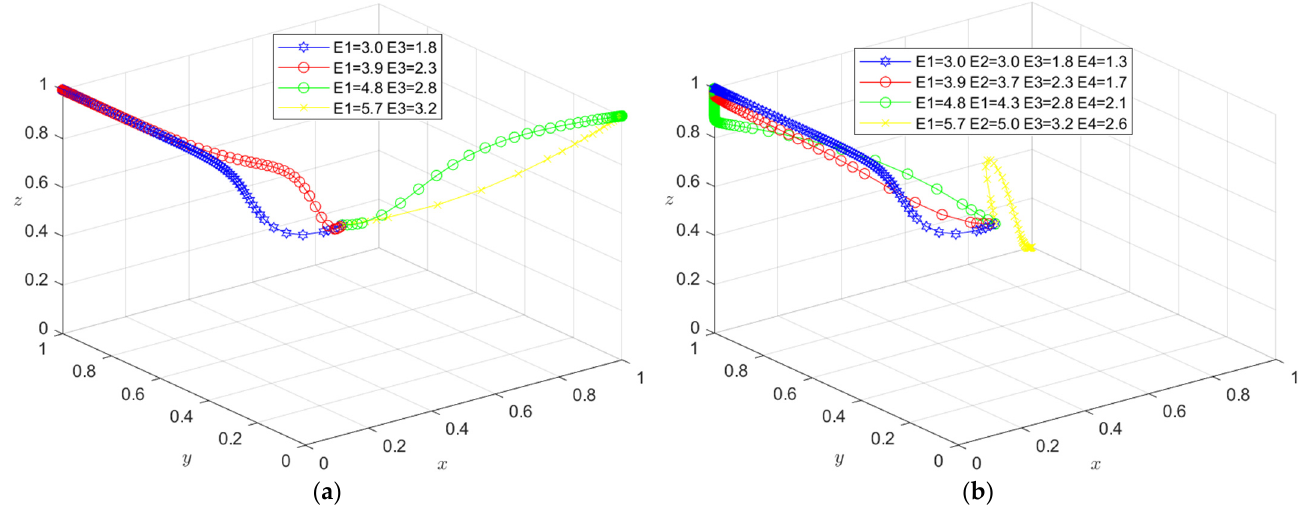
Figure 11. ( a ) Evolution path of the developer, general contractor and government under different government punishments E 1 , E 3 . ( b ) Evolution path of the developer, general contractor, and government under different government punishments E 1 , E 2 , E 3 , E 4 .